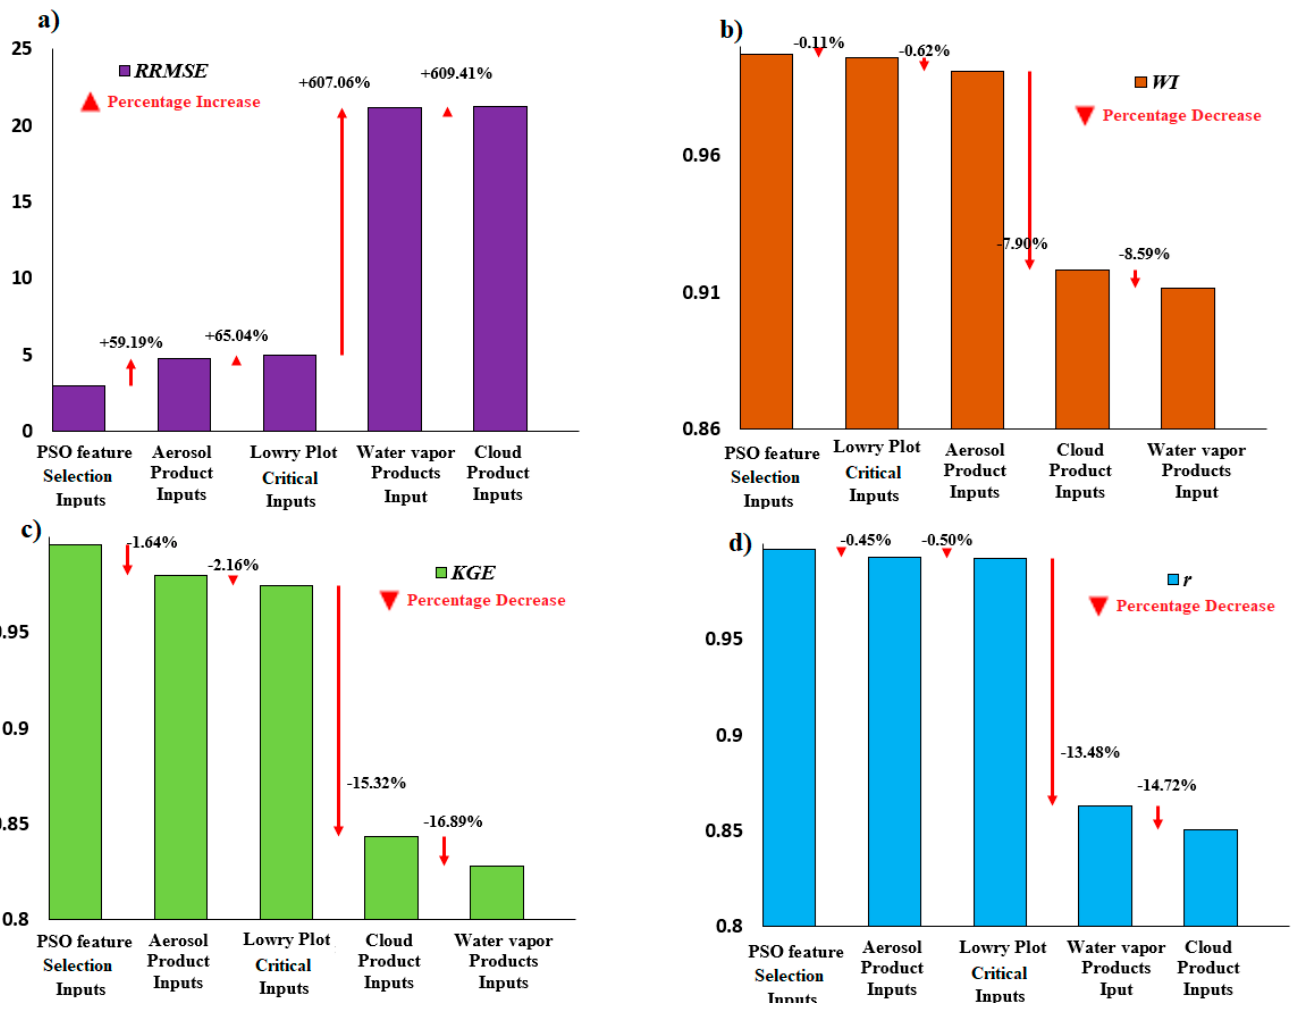
Figure 7. Sensitivity analysis of the relevant MODIS satellite-derived inputs variables: aerosol, cloud and water vapour, in terms of their: ( a ) relative root mean squared error ( RRMSE ), ( b ) Willmott’s index ( WI ), ( c ) Kling–Gupta efficiency, ( KGE ), and ( d ) correlation coefficient ( r ).